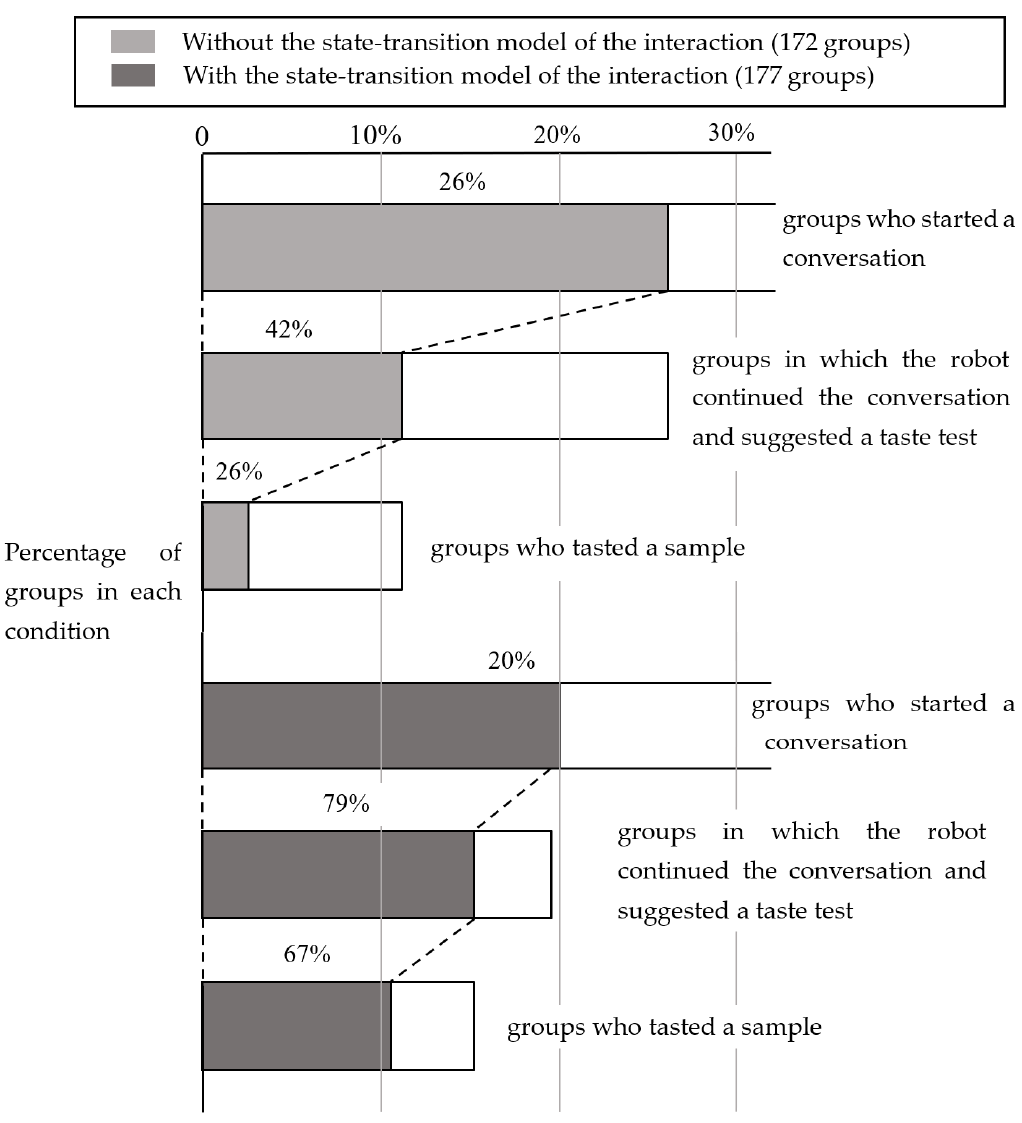
Figure 18. Percentage of customers during each stage of customer service under two conditions.